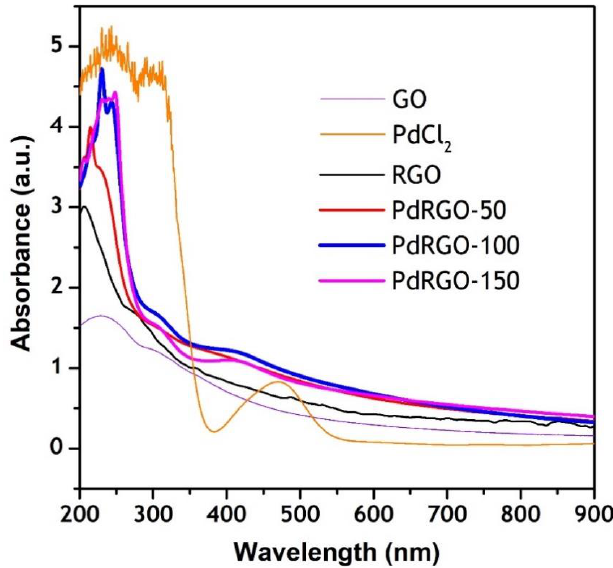
Figure 1. UV-Visible absorption pattern of graphene oxide (GO), PdCl 2 , reduced graphene oxide (RGO), and green synthesized palladium-reduced graphene oxide (Pd-RGO) nanoparticles from Coleus amboinicus.